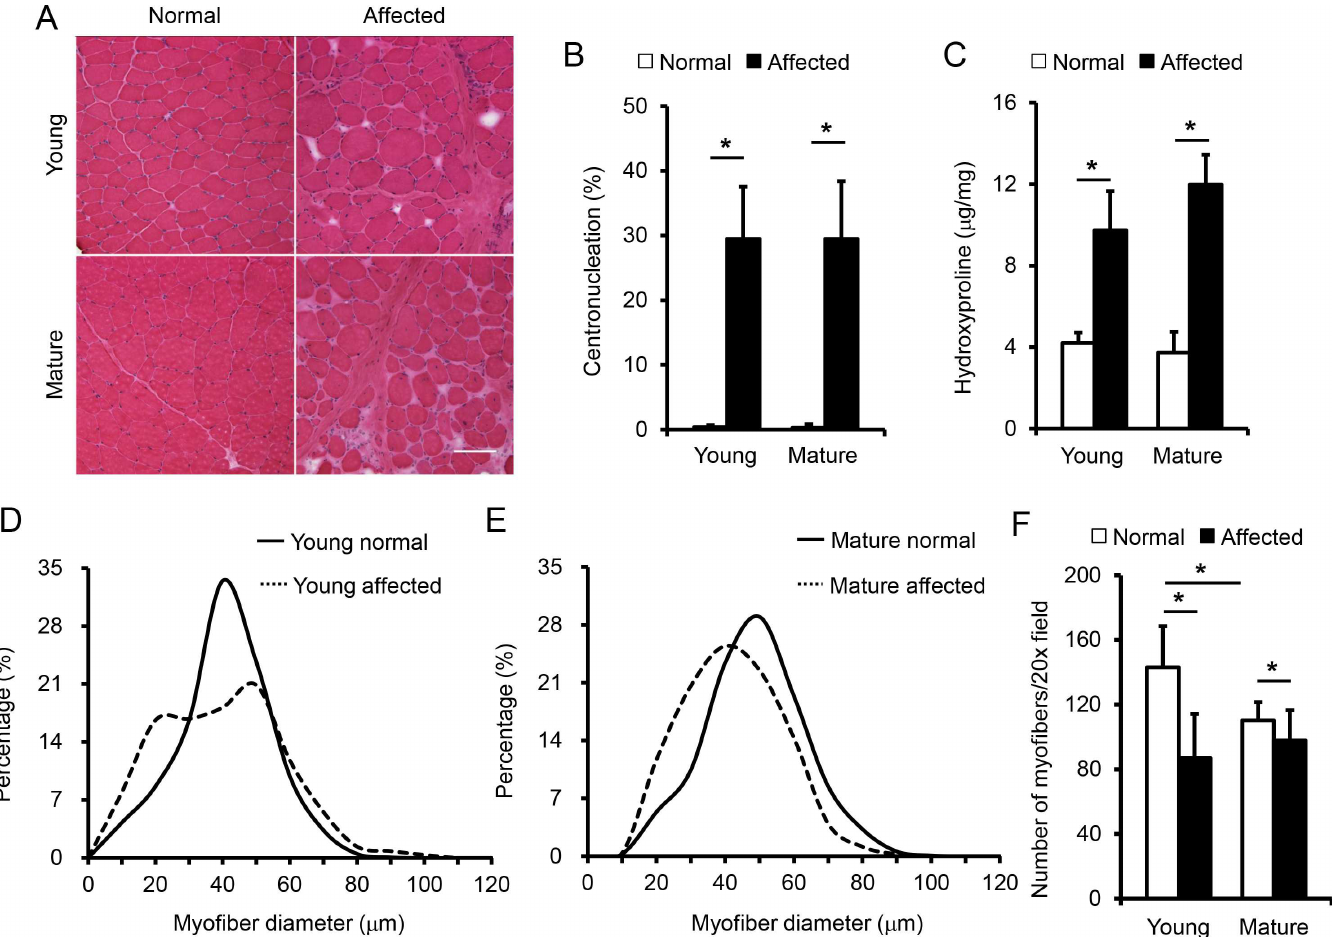
Fig 5. Quantitative evaluation of muscle histology and fibrosis. (A) Representative photomicrographsof the biceps femoris muscle of youngnormal, youngaffected, mature normal and mature affected dogs. Scale bar, 100 μ m. Enlargedimage is presentedin S1 Fig. (B) Quantification of myofibers that containcentrallylocalizednuclei.The sample size for young normal, young affected, mature normal and mature affected groups are 4, 3, 2 and 3 dogs, respectively. There was a significantdifference betweennormal and affected dogs in the mature age groups. (C) Quantification of muscle fibrosis by the hydroxyproline assay. The sample size for young normal, young affected, mature normal and mature affected groups are 3, 3, 2 and 3 dogs, respectively. There was a significantdifference betweennormal and affected dogs in both age groups, but no significantdifference between youngand mature affected dogs. (D) Distributionof the minimum Feret diameterin young normal(n = 1,441 myofibers) and youngaffected (n = 1,104 myofibers) dogs. (E) Distribution of the minimum Feret diameterin mature normal(n = 1,045 myofibers) and mature affected (n = 1,225 myofibers) dogs. (F) Quantification of myofiber density per 20x filed. The numbers of 20x field counted in youngnormal, youngaffected, mature normal and mature affected dogs were 37, 30, 24 and 20, respectively. There was a significantdifference betweenyoung and mature normal dogs and betweennormal and affected dogs. Open bar, normal dogs; filled bar, affected dogs. Asterisk, significantly